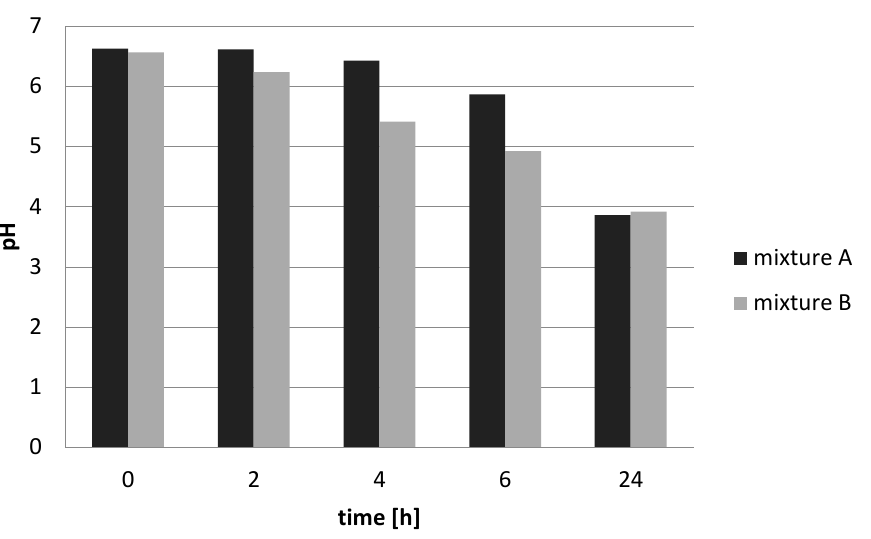
Figure 5. Development of pH of starter culture combinations consisting of the starter strains Lb. helveticus 314, L. fermentum 317, S. thermophilus 252, Lb. delbrueckii 328M, and the yeast S. cerevisiae strain 370 (mixture A) or the lactic acid bacteria strains without the yeast (mixture B) during 24 h fermentation in milk. pH determinations were done as single determinations.